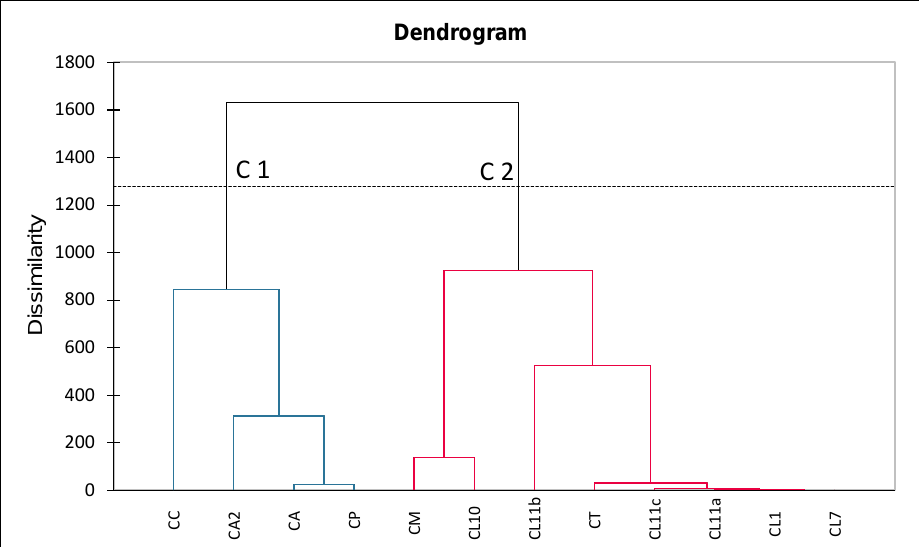
Figure 4. Principal component analysis ordination of 12 oil samples (observations). Axes (F1 and F2 correspond to the first and second principal component responsible. Axis F1 accounts for ca. 34.35% and axis F2 for a further 19.24% of the total variance. 3. Discussion